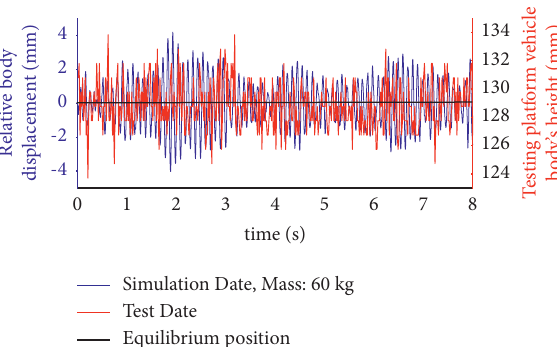
Figure 14: Test and simulation time-domain results of the vehicle’s body height and relative displacement under 60kg load.